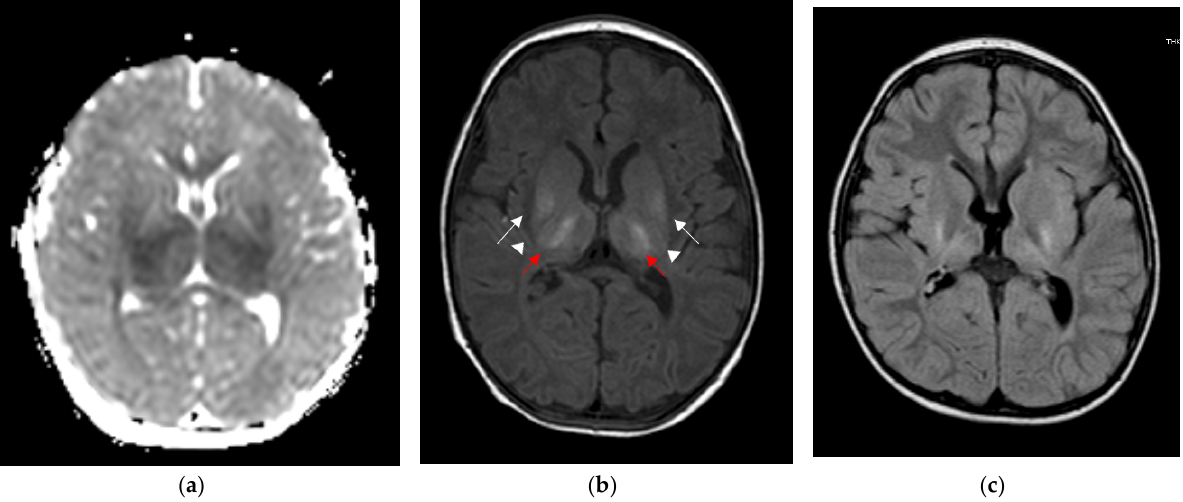
Figure 5. Brain MRI scans of case 1. ( a ) At 5 days of life, DWI showed a symmetric reduction in the apparent diffusion coefficient of thalami and putamen. ( b ) At 21 days of life, T1-weighted axial spin echo sequence showed severe bilateral abnormally increased signal intensities in the ventro-lateral thalamic nuclei (red arrows) and posterior aspect of the putamen (white arrow), with loss of normal signal intensity in the posterior limb of the internal capsule (arrowheads). ( c ) FLAIR sequence at 30 months showed atrophic and gliotic evolution of thalami and lenticular nuclei, and quantitative reduction in the posterior periventricular white matter.